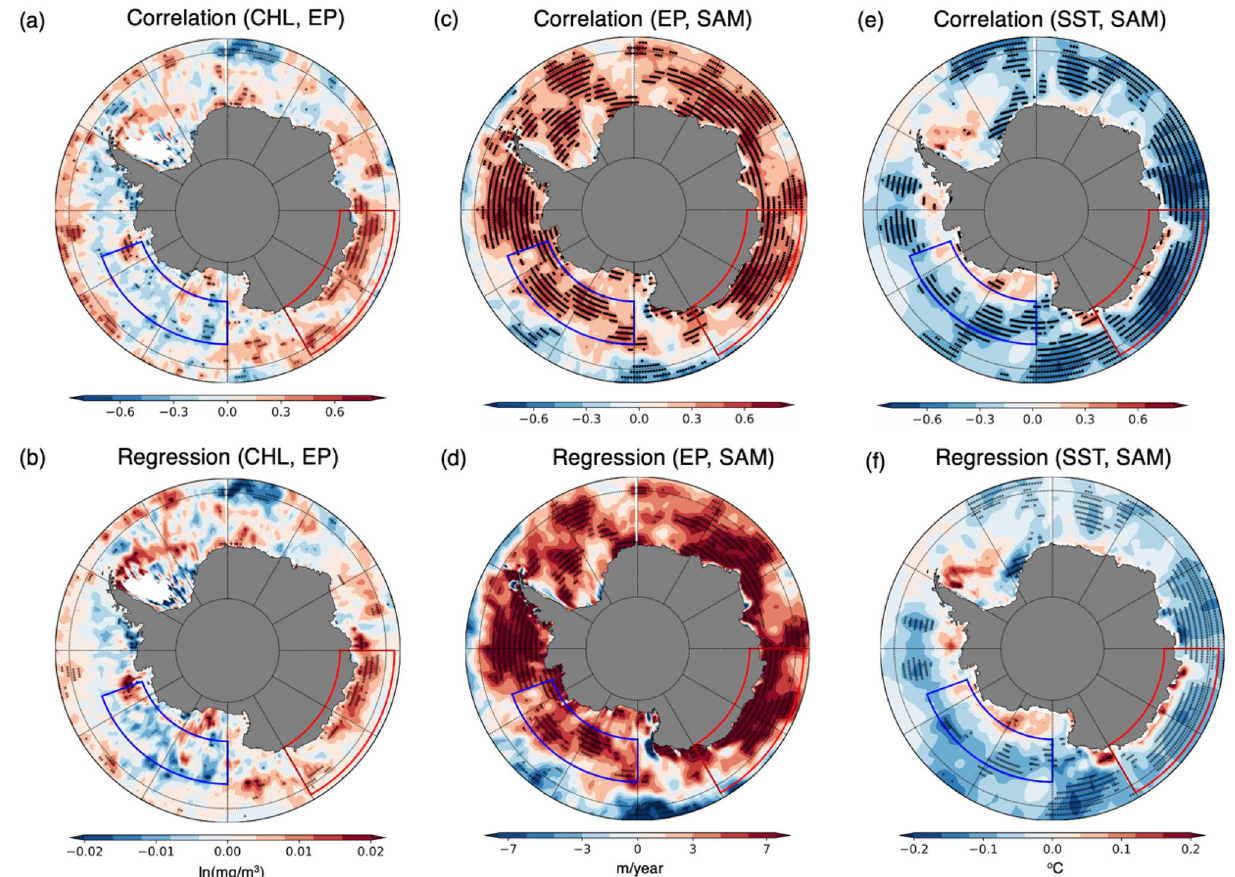
Figure 3. Correlation and regression maps ( a , b ) between the chlorophyll concentration and Ekman pumping velocity and between the SAM index and ( c , d ) Ekman pumping velocity, (e, f) SST. The 95% significant correlation ( p value < 0.05) regions are denoted by black dots. White areas indicate the region where satellites have not observed chlorophyll for at least three years due to sea-ice cover or cloud.